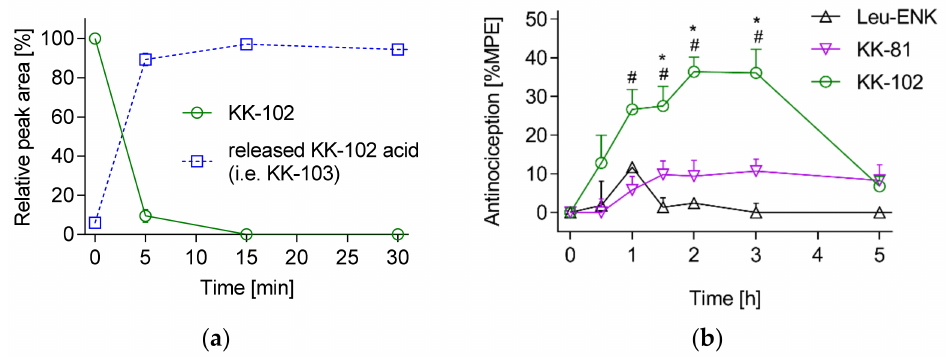
Figure 2. Stability of KK-102 containing a C -terminal ester and release of the corresponding acid KK-103 in female CD-1 mouse plasma ( a ) and antinociceptive activity in the hot-plate model on female CD-1 mice comparing the percent %MPE of three representative Leu-ENK analogs (13 mg/kg, s.c. injection, panel b ). Data = mean ± SEM (a: n = 3, b: n = 6). Statistical comparisons were performed using a two-way ANOVA with multiple comparisons and Tukey post hoc test. * p < 0.001: KK-102 compared to Leu-ENK, # p < 0.001: KK-102 compared to